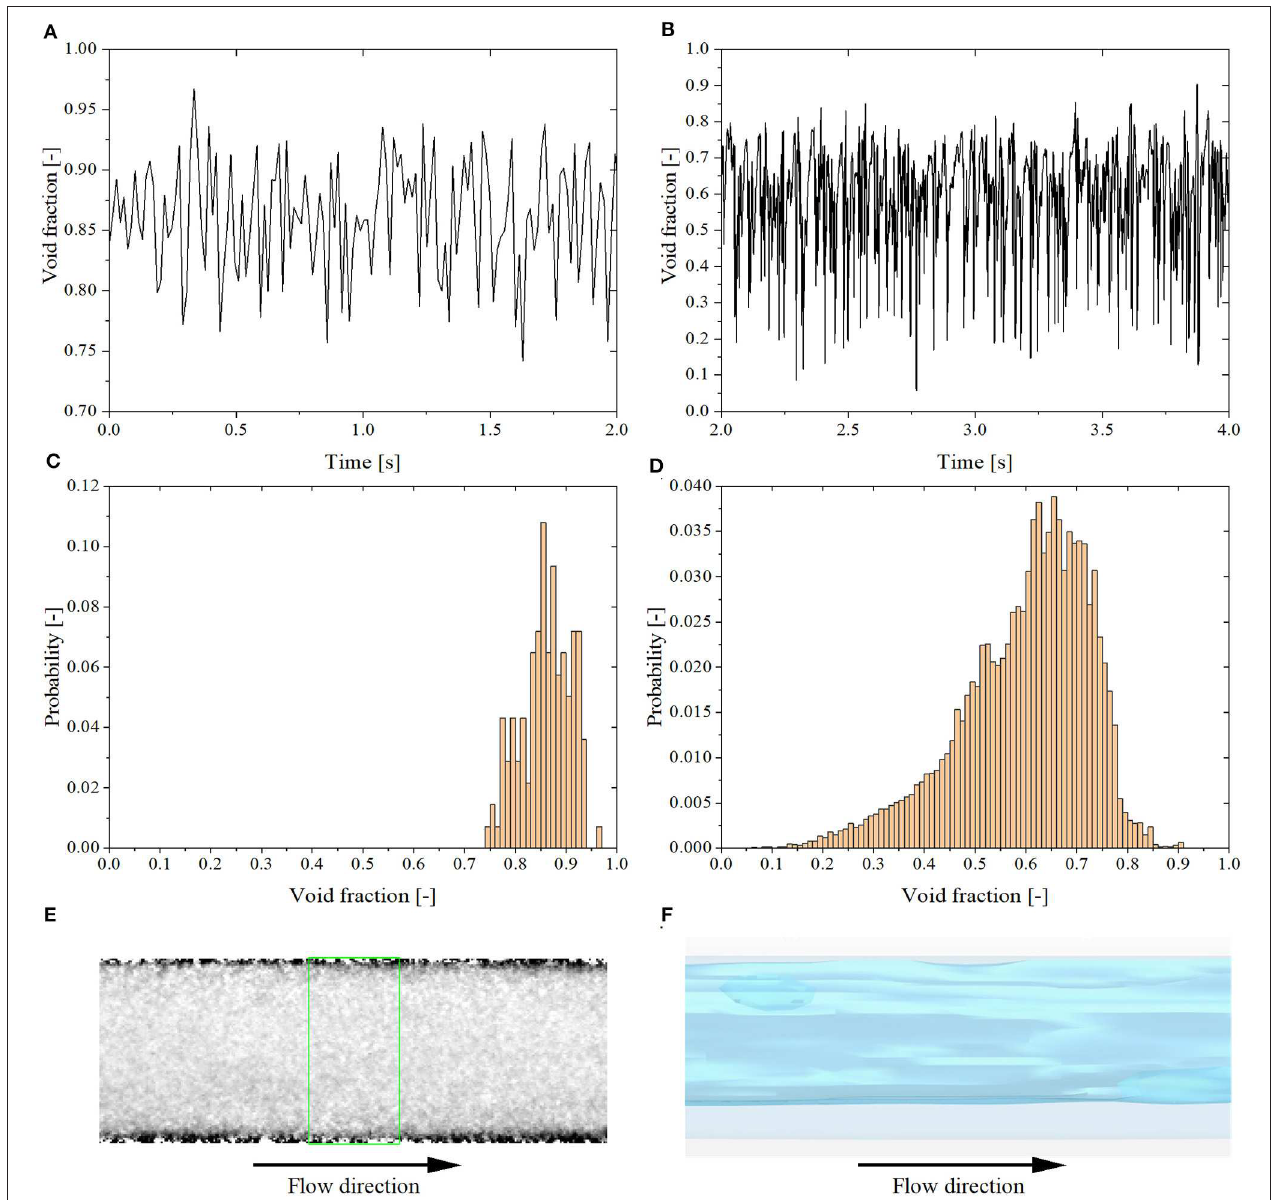
FIGURE 11 | Results of test No. 11. (A) Experimental void fraction time evolution. (B) Simulation void fraction time evolution. (C) Experimental void fraction histogram. (D) Simulation void fraction histogram. (E) X-ray void fraction contrast image. (F) Void fraction isosurface